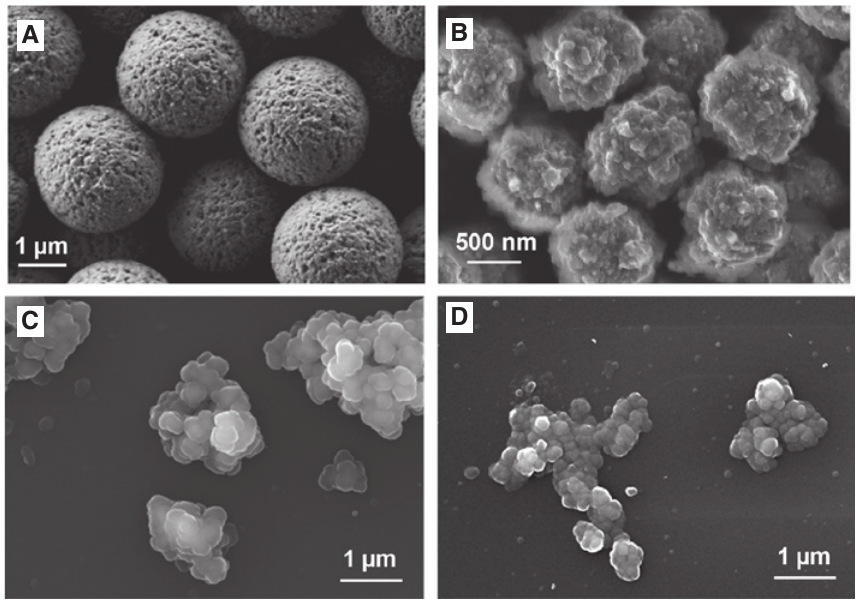
Figure 4: Scanning electron microscopy (SEM) images of MP of different types and from different providers. (A and B) Dynabeads, 2.8 and 1 μ m, respectively, from Invitrogen (Thermo Fisher Scientific). (C and D) Multicore MP, 1 μ m and 200 nm in diameter, respectively, produced by